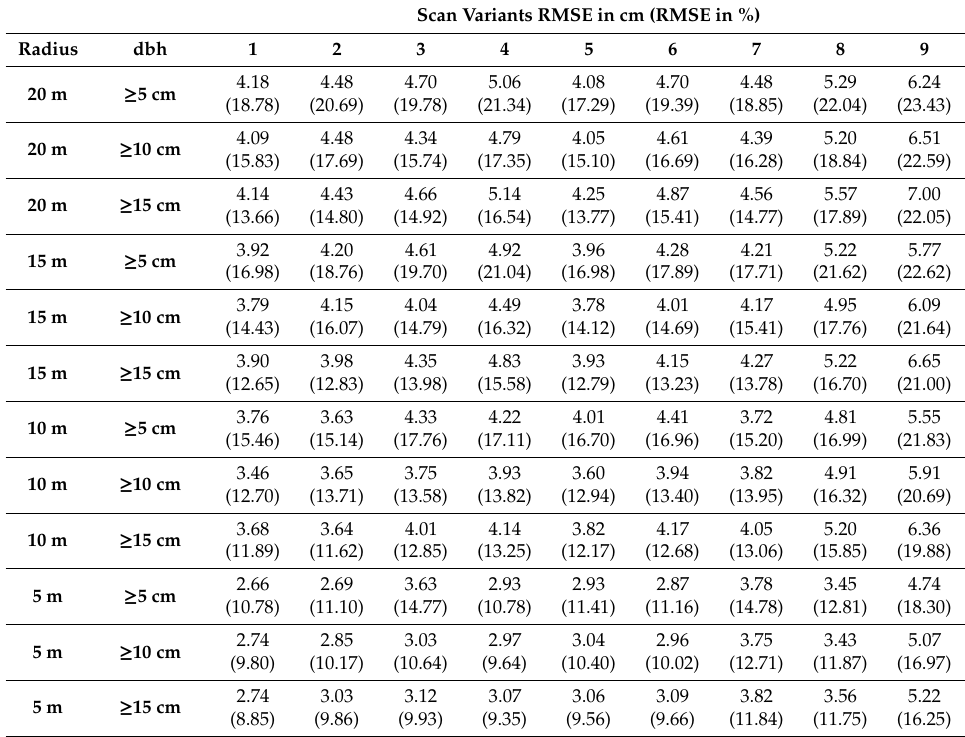
Figure 4. Overall accuracies for di ff erent scan variants, lower dbh thresholds, and plot radii. Black squares represent mean detection rates. Table 3. Average root mean square error (RMSE) of automatic dbh measurements over all 23 sample plots and depending on scan variant, lower dbh threshold, and plot